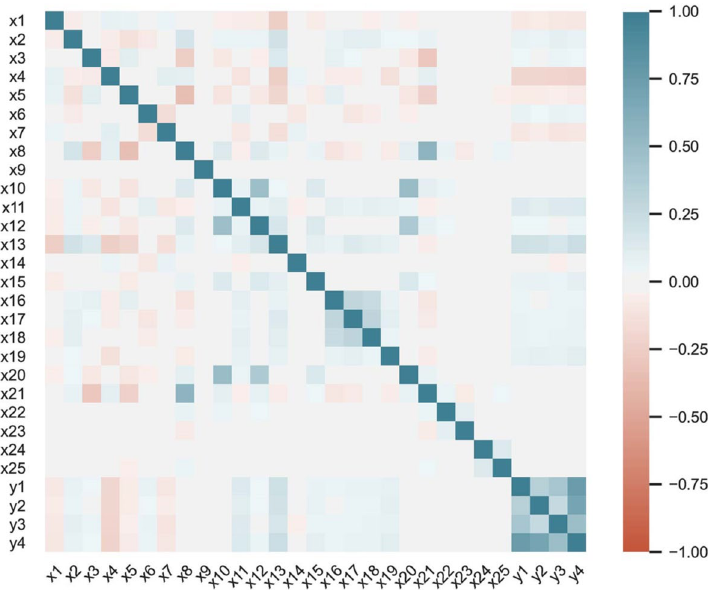
Figure 1. The bivariate correlation between the inputs and outputs. × 1: sleeping-time cat. (category); × 2: screen time cat.; × 3: family-size cat.; × 4: life satisfaction cat.; × 5: residence area; × 6: gender; × 7: physical activity cat.; × 8: SES cat.; × 9: self-rated health cat. (SRH); × 10: BMI cat.; × 11: breakfast cat.; × 12: body image cat.; × 13: age cat.; × 14: the number of close friends cat.; × 15: weight-reduction plan; × 16: salty-snack cat.; × 17: sweetened beverage consumption cat.; × 18: fast food consumption cat.; × 19: smoker; × 20: abdominal obesity; × 21: mother education cat.; × 22: birth-weight cat.; × 23: milk type during infancy; × 24: the family history of sudden death; × 25: the family history of cancer; y1: worriedness symptom; y2: depression symptom; y3: mild-to- moderate emotional symptoms; y4: psychiatric symptoms. The entire ordinal variables were encoded ascending (e.g., mild to severe, or seldom to daily), except for × 9 (1: good, 2: moderate, 3: bad), × 11 (1: non-skipper, 2: semi-skipper, 3: skipper), and × 17 (1: daily, 2: weekly, 3: seldom/never).